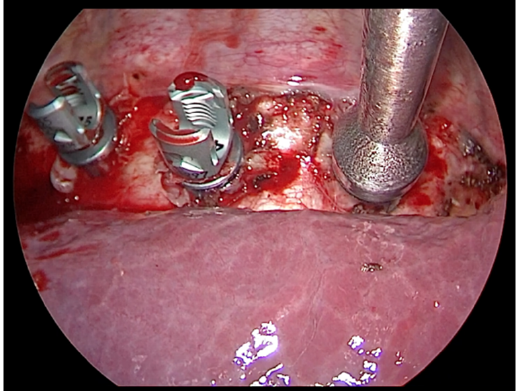
Figure 6. Vertebral bodies are instrumented with hydroxyapatite-coated screws and pronged staples.